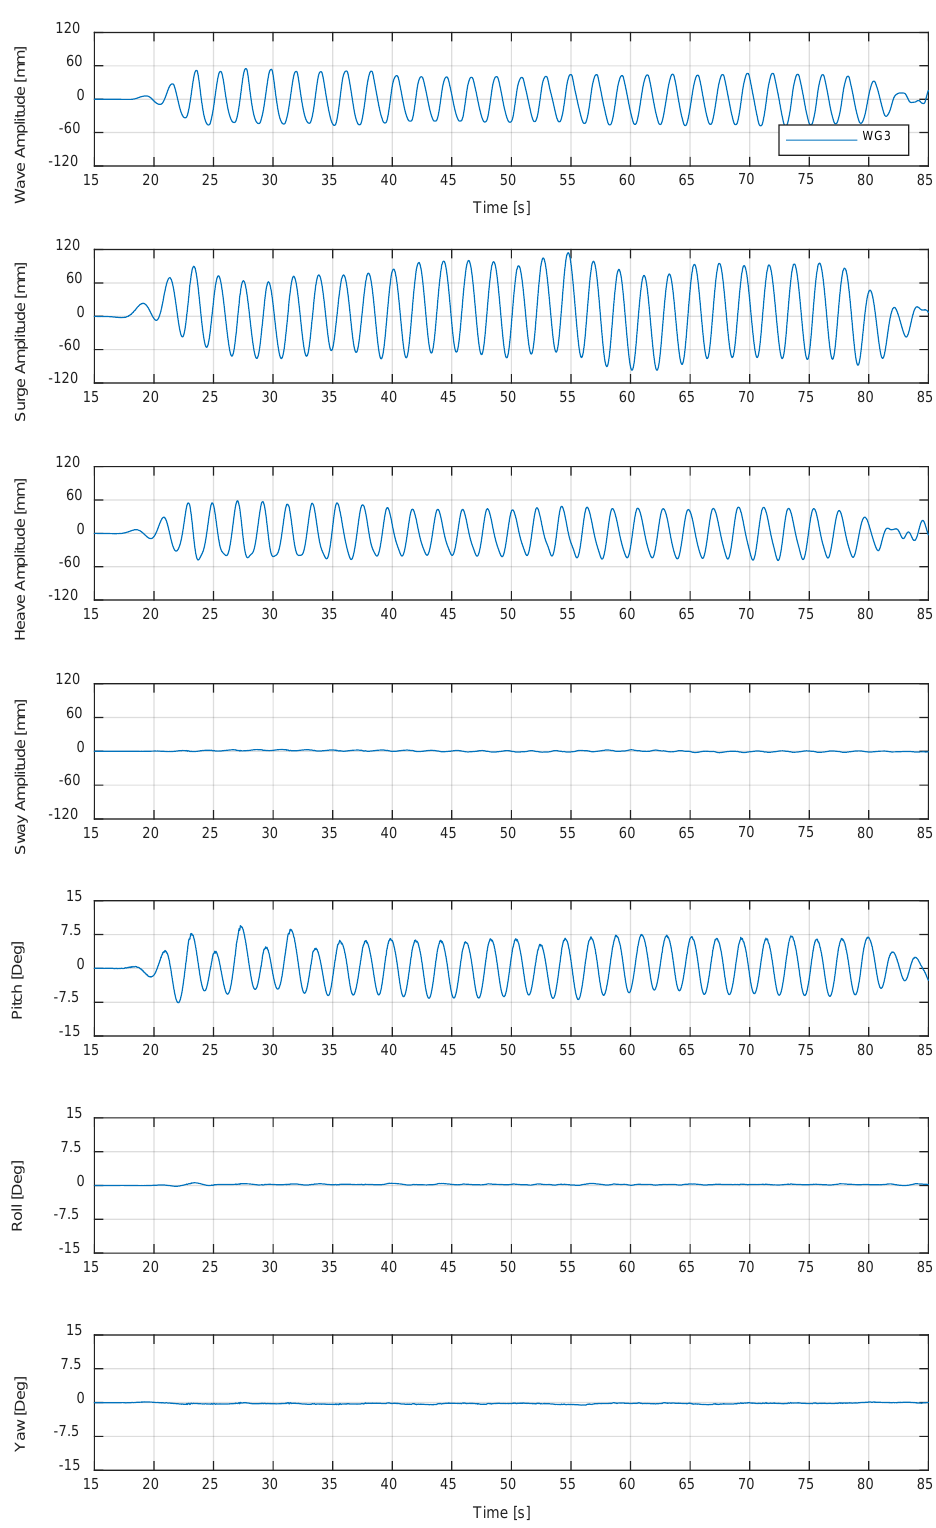
Figure 12. OWC WEC motions with incident waves (WG3, surge, heave, sway, pitch, roll, and yaw) for test H14 (d = 0.625 m, H = 0.1 m, and T = 2.1 s).